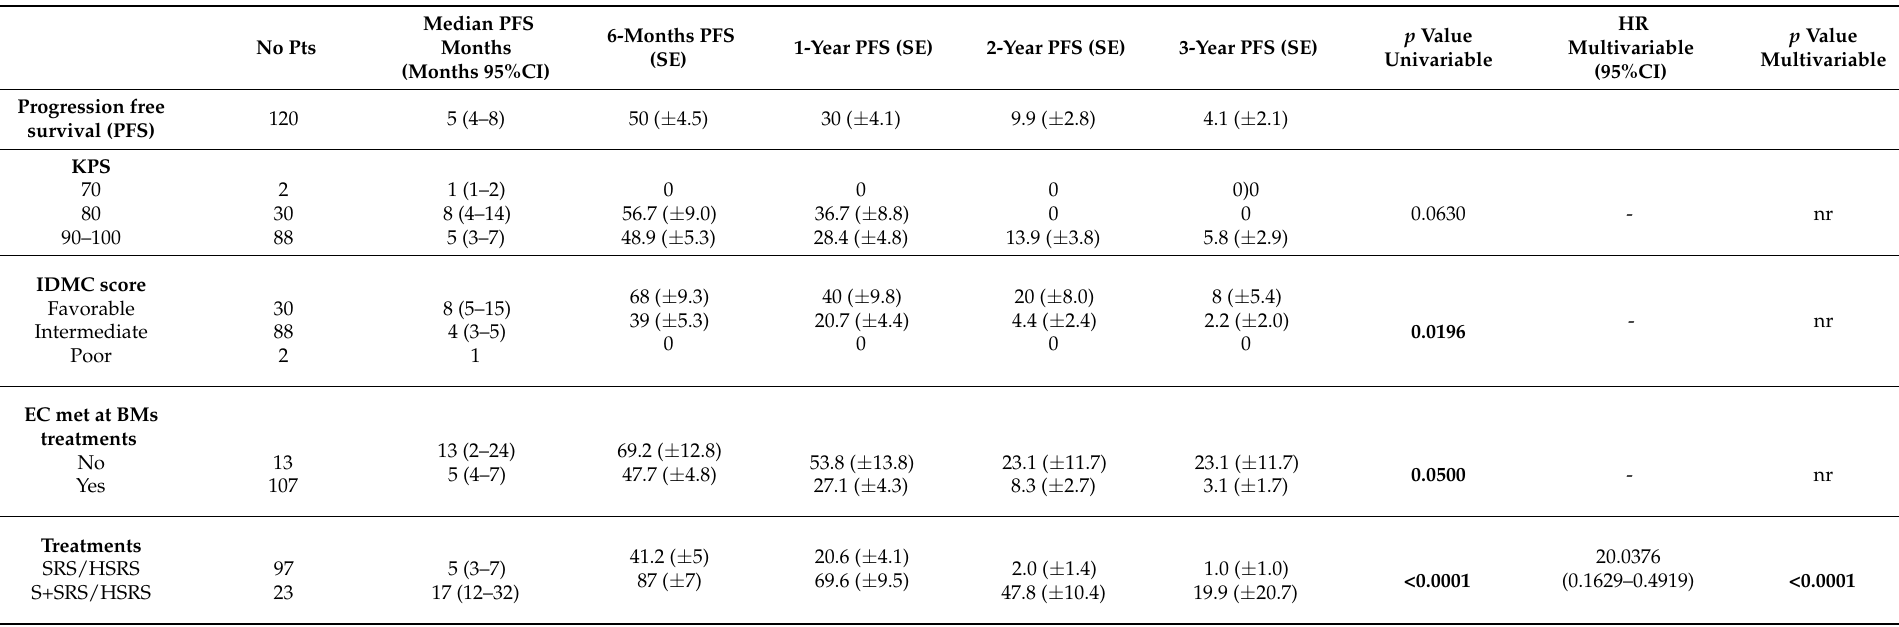
Table 3. Kaplan–Meier progression-free survival (PFS) and overall survival (OS) according to subgroup analyses from BM